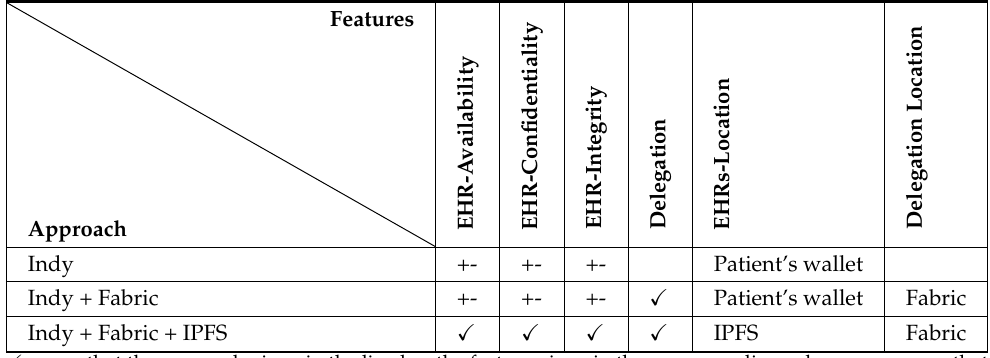
Table 12 resumes the main computations (hash, signature, signature verification,